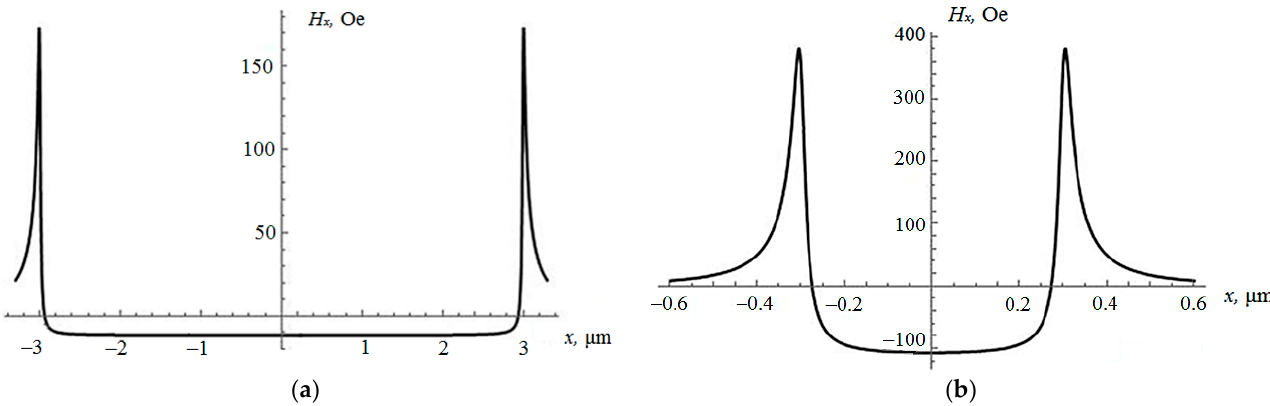
Figure 2. Dependence of the strength projection H x on the X coordinate along the semi-major axis of the upper ellipsoid: ( a ) for a = 3 μ m, b = 1 μ m, c = 5 nm, and d = 3 nm; ( b ) for a = 0.3 μ m, b = 0.1 μ m, c = 5 nm, and d =3 nm.